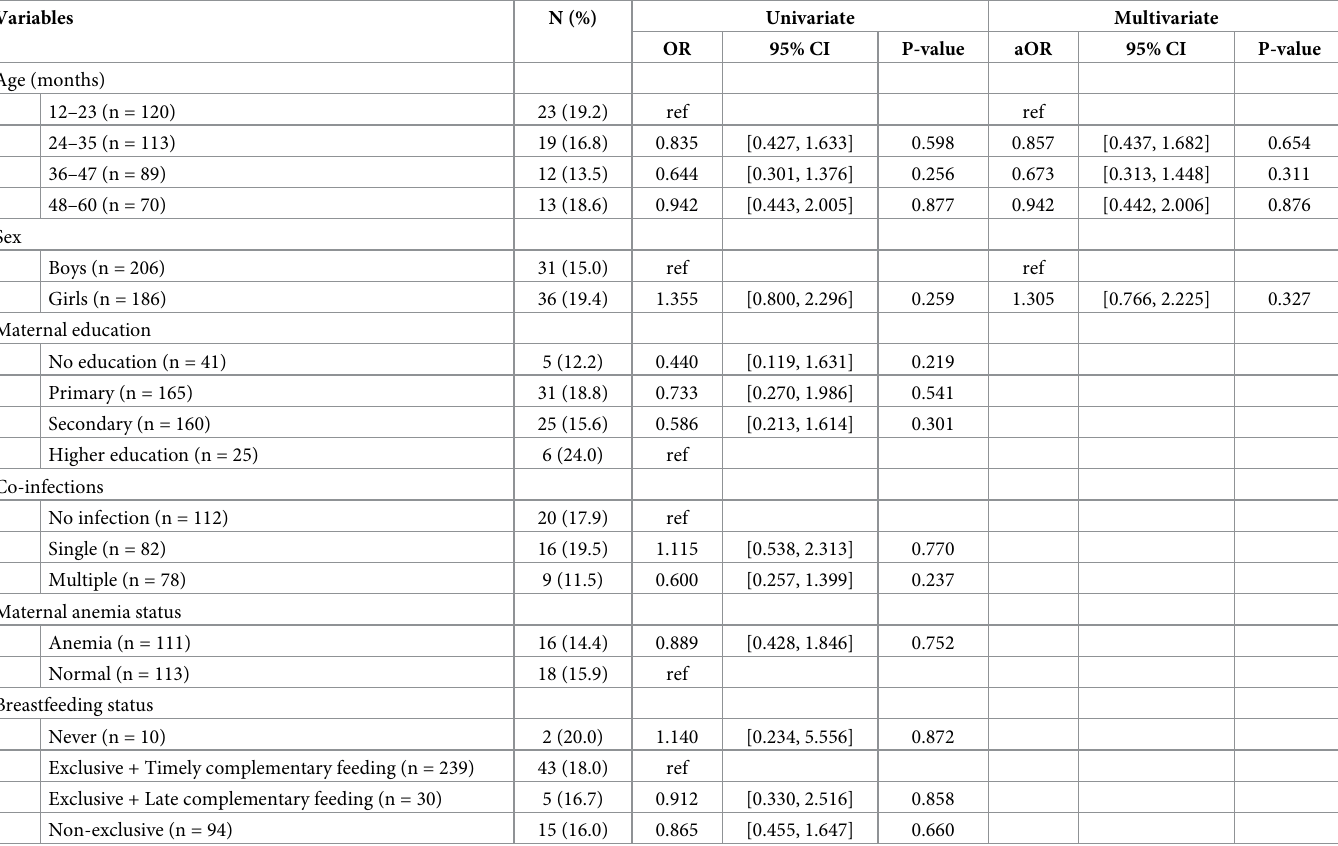
Table 5. Factors associated with weight-for-height Z-score (WHZ) among preschool-age children (PSC) in this study (n =